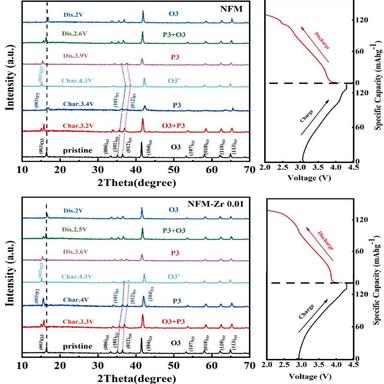
Ex-situ XRD spectra of (a) NFM and (b) NFM-1 %Zr 2–4.3 V charge and discharge curves.